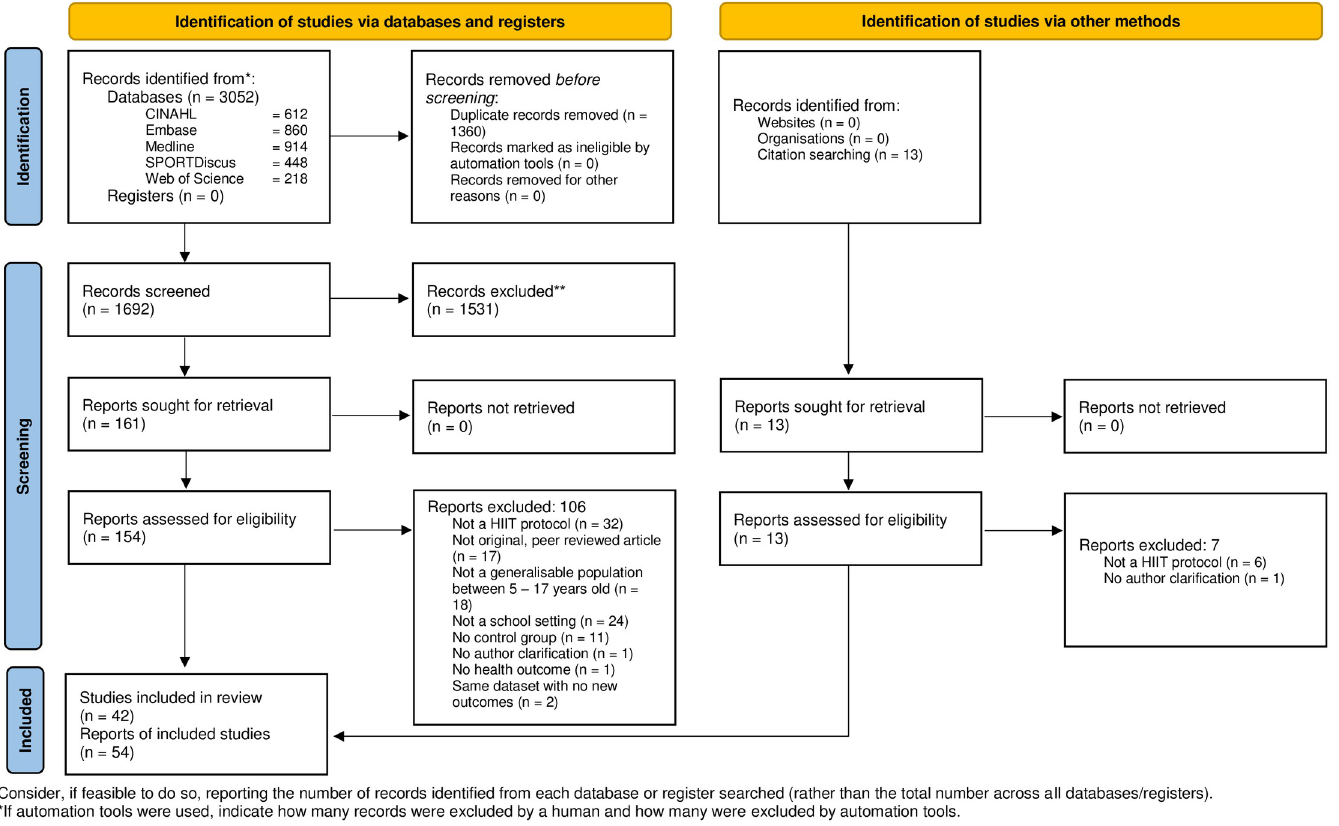
Fig 1. Preferred Reporting Items for Systematic Reviews and Meta-Analyses (PRISMA) flow diagram. HIIT = high-intensity interval training; WoS = Web of Science.